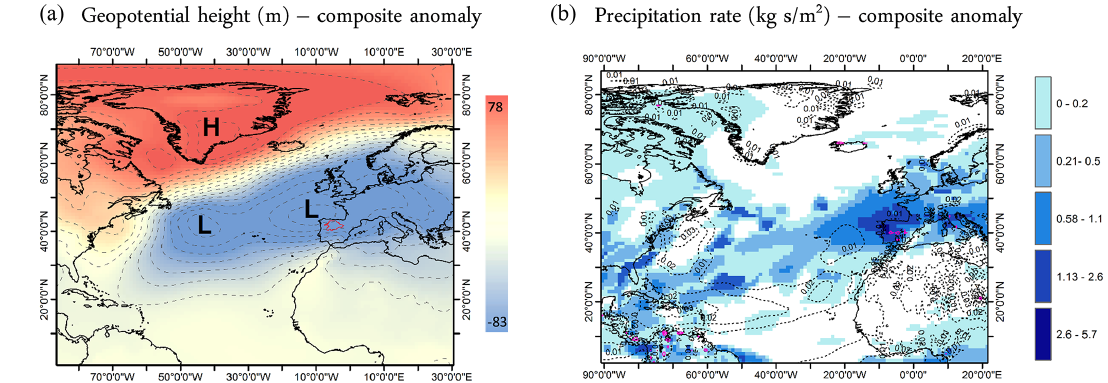
Figure 9. (a) Composite monthly anomaly of the geopotential at 500hPa. (b) Composite seasonal precipitation rate retrieved from 20CRV3 (blue-coloured) and composite divergence for the 10d prior to the peak of each flood at 250hPa (dotted) and convergence at sea level (purple line). L: low pressure; HL: high